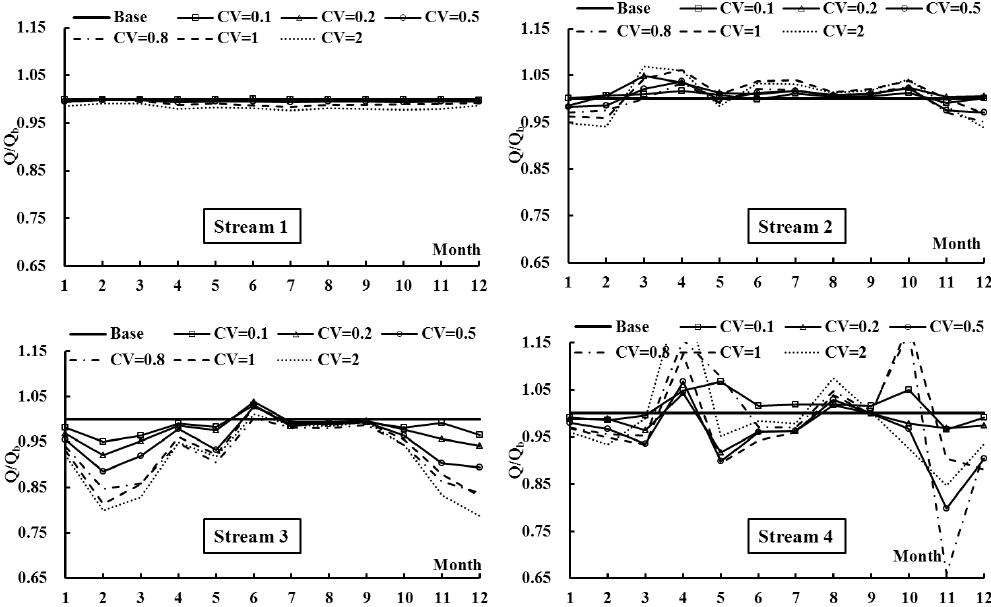
Figure 8. Stream–aquifer leakages of different streams from refined model.